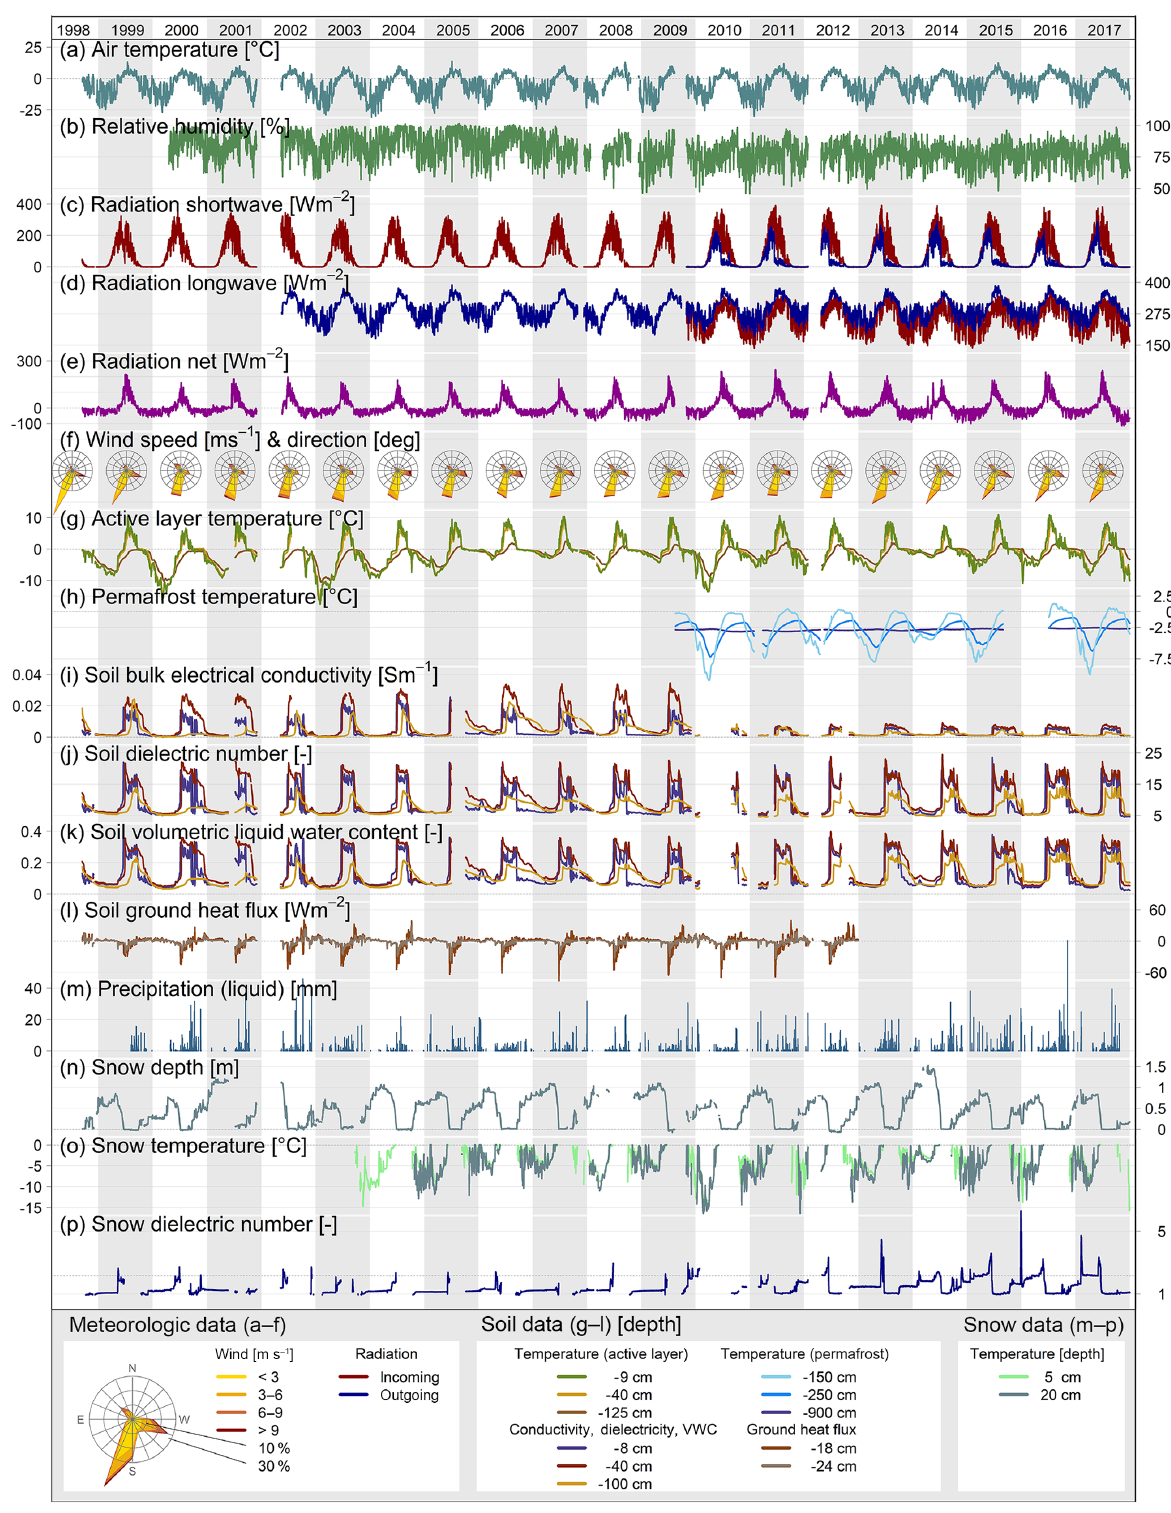
Figure 3. Time series of Bayelva data provided in this paper. (a) – (f) meteorological data, (g) – (l) : soil and subsurface data, (m) – (p) : snow data. The data are organized following the structure of Appendix G. Further details on the sensors and periods of operation are given in Table 2. This plot (divided in three parts for better visibility) is also provided in Appendix